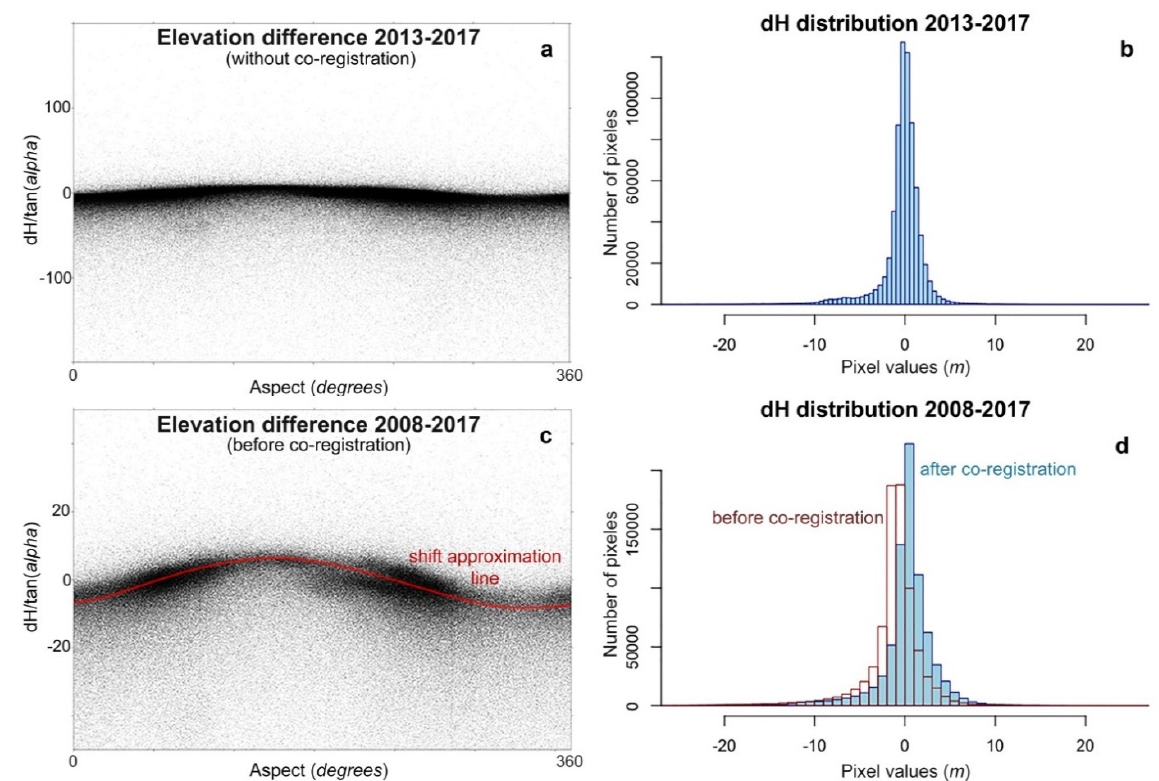
Figure 3. Elevation difference distribution before and after co-registration. ( a ) Elevation difference 2013–2017. The shift between two DEMs was considered as negligible. Then co-registration procedure was not applied; ( b ) dH distribution 2013–2017; ( c ) elevation difference 2008–2017. Sinusoidal shift approximation line shows the necessity of co-registration application; ( d ) dH distribution 2008–2017.